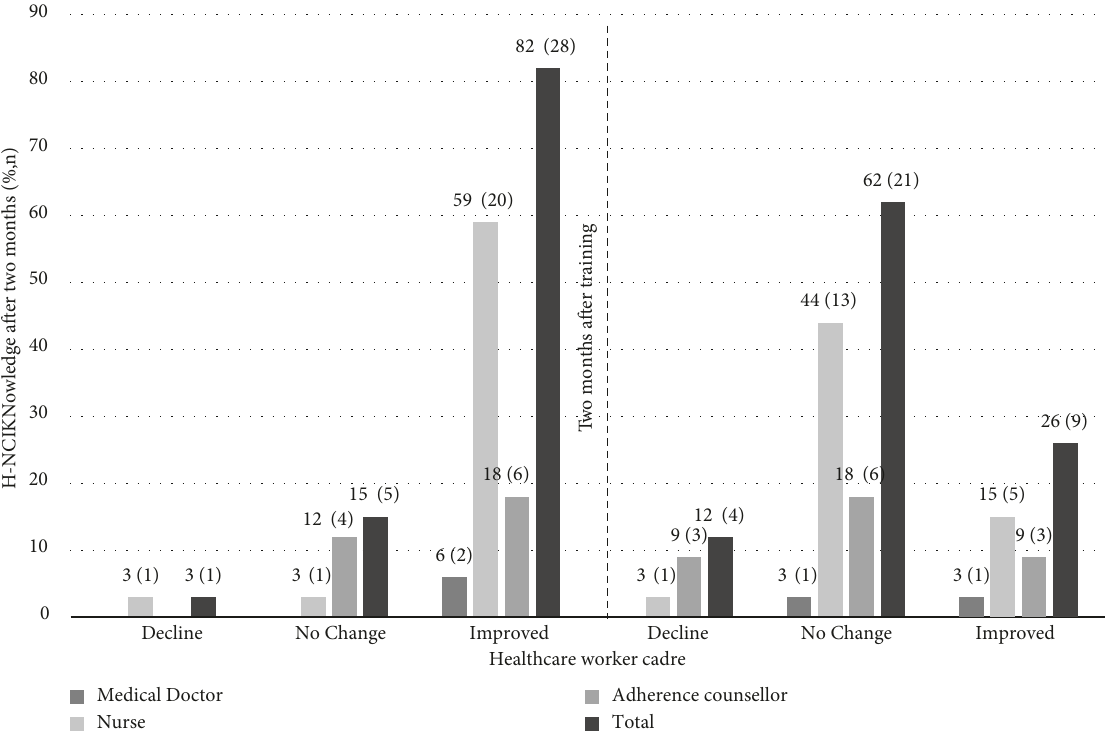
Figure 2: Healthcare workers’ HIV-associated NCI knowledge scores before and after